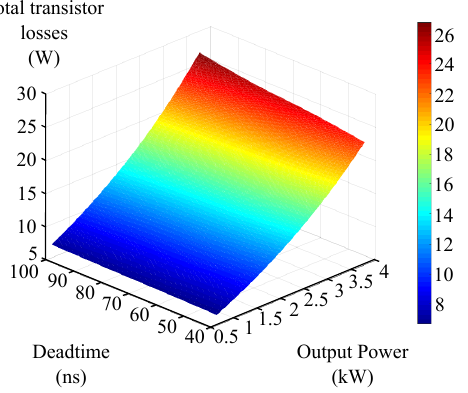
Figure 12. Total transistor losses as a function of deadtime and output power.